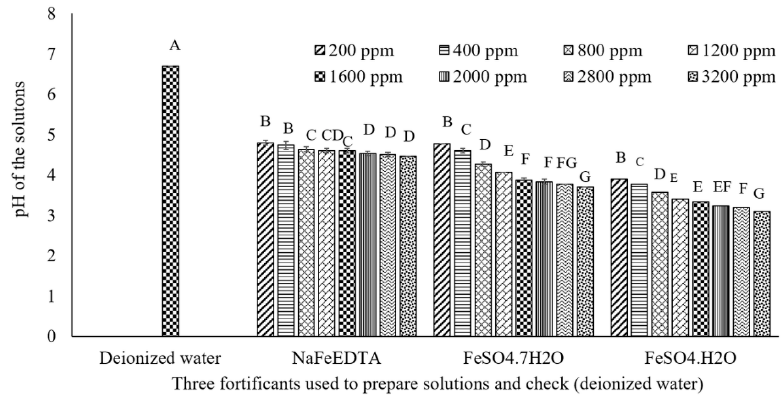
Figure 5. pH of Fe solutions prepared with three fortificants (NaFeEDTA, FeSO 4 · 7H 2 O, and FeSO 4 · H 2 O) ranging in concentration from 200–3200 ppm. Different letters within each figure represent significant differences ( p < 0.05).